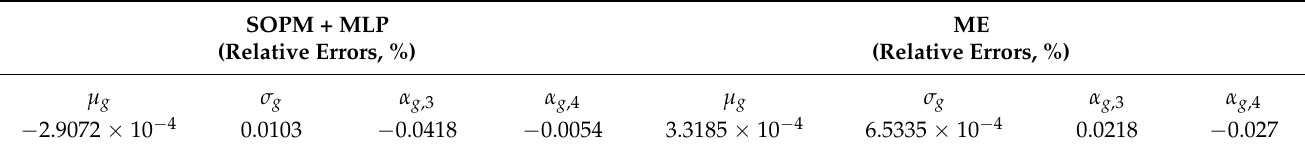
Table 5. Relative errors of the first four statistical moments calculated by SOPM + MLP and ME for Example